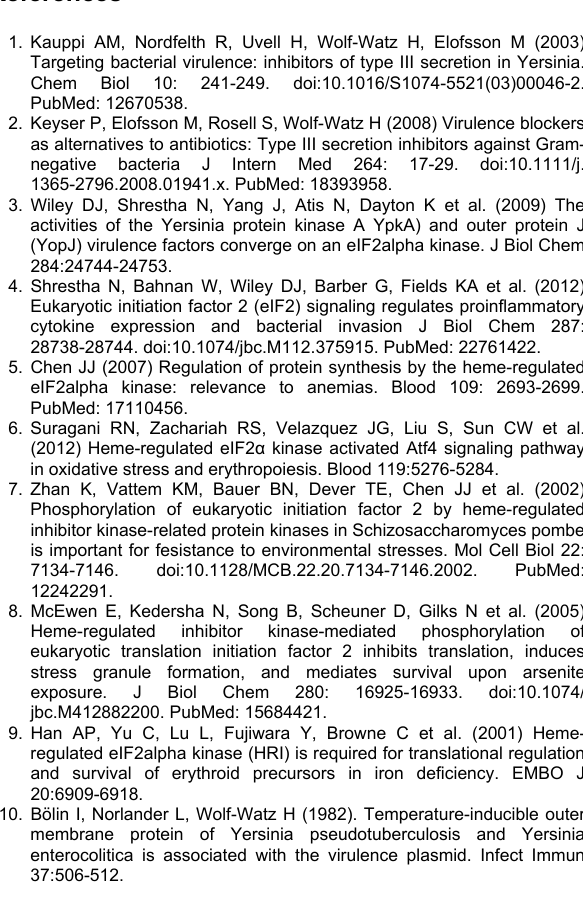
occurred in Hri -/- cells.